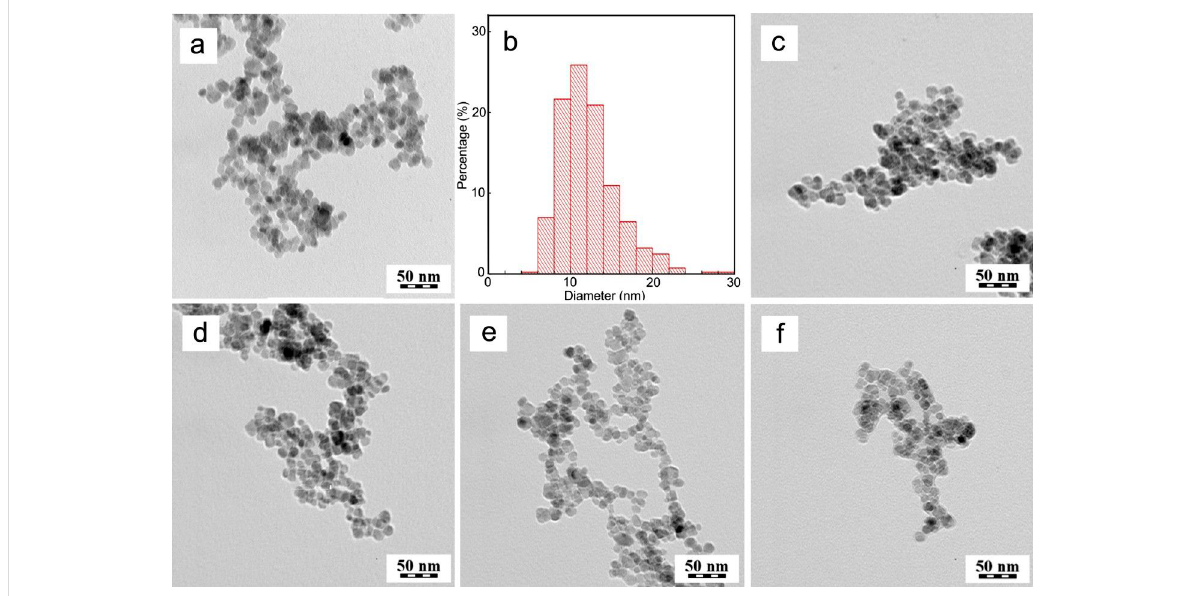
Figure 2: TEM micrographs of (a) γ -Fe 2 O 3 , (c) γ -Fe 2 O 3 @Hep, (d) γ -Fe 2 O 3 @Hep-CS-H, (e) γ -Fe 2 O 3 @Hep-CS-G, and (f) γ -Fe 2 O 3 @Hep-CS-P nano- particles. (b) Size-distribution histogram of γ -Fe 2 O 3 nanoparticles.